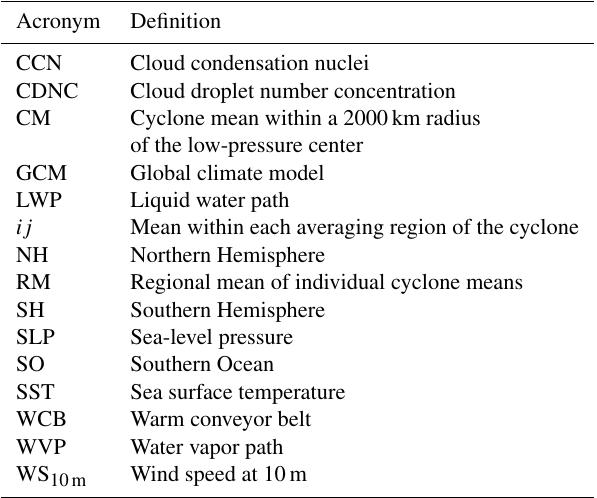
Table 1. Acronyms and subscripts used in this